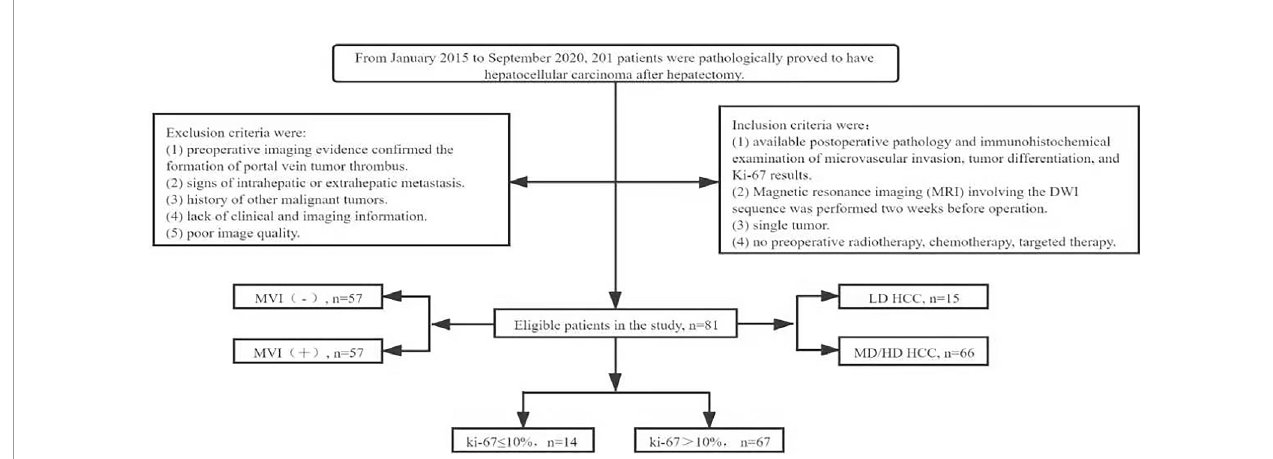
FIGURE 1 | Flow chart of patient screening in the study. MVI, microvascular invasion; LD, low differentiation; MD, medium differentiation; HD, high differentiation; HCC, hepatocellular